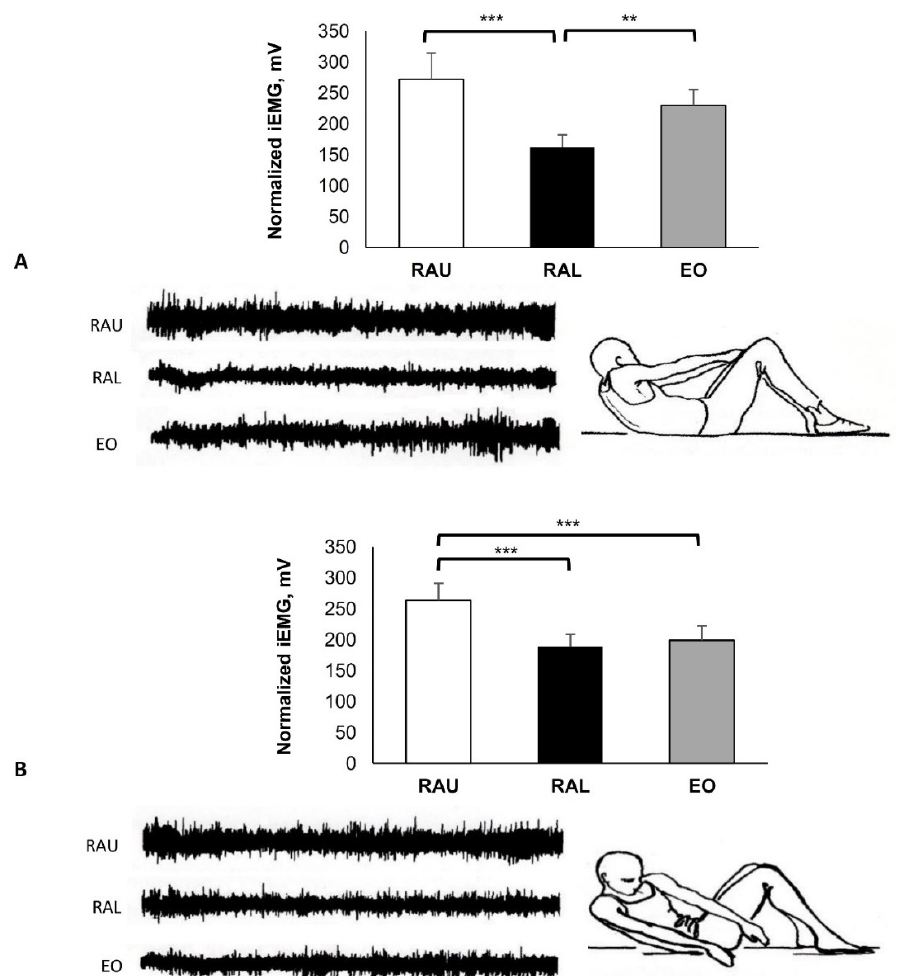
Figure 7. Supine position with bent knees and no stabilization of the lower limbs. Rotation of the trunk to ( A ) the left and ( B ) the right side of the body with isometric contraction for 10 s. The surface electrodes were placed on the right side of the external oblique muscle. Group mean electric activity during the exercise. iEMG indicates surface electric activity. Raw EMG activity of the three muscles from one participant. RAU = rectus abdominis upper part; RAL = rectus abdominis lower part; EO = external oblique. Differences between muscles: ** p < 0.01; *** p < 0.001.